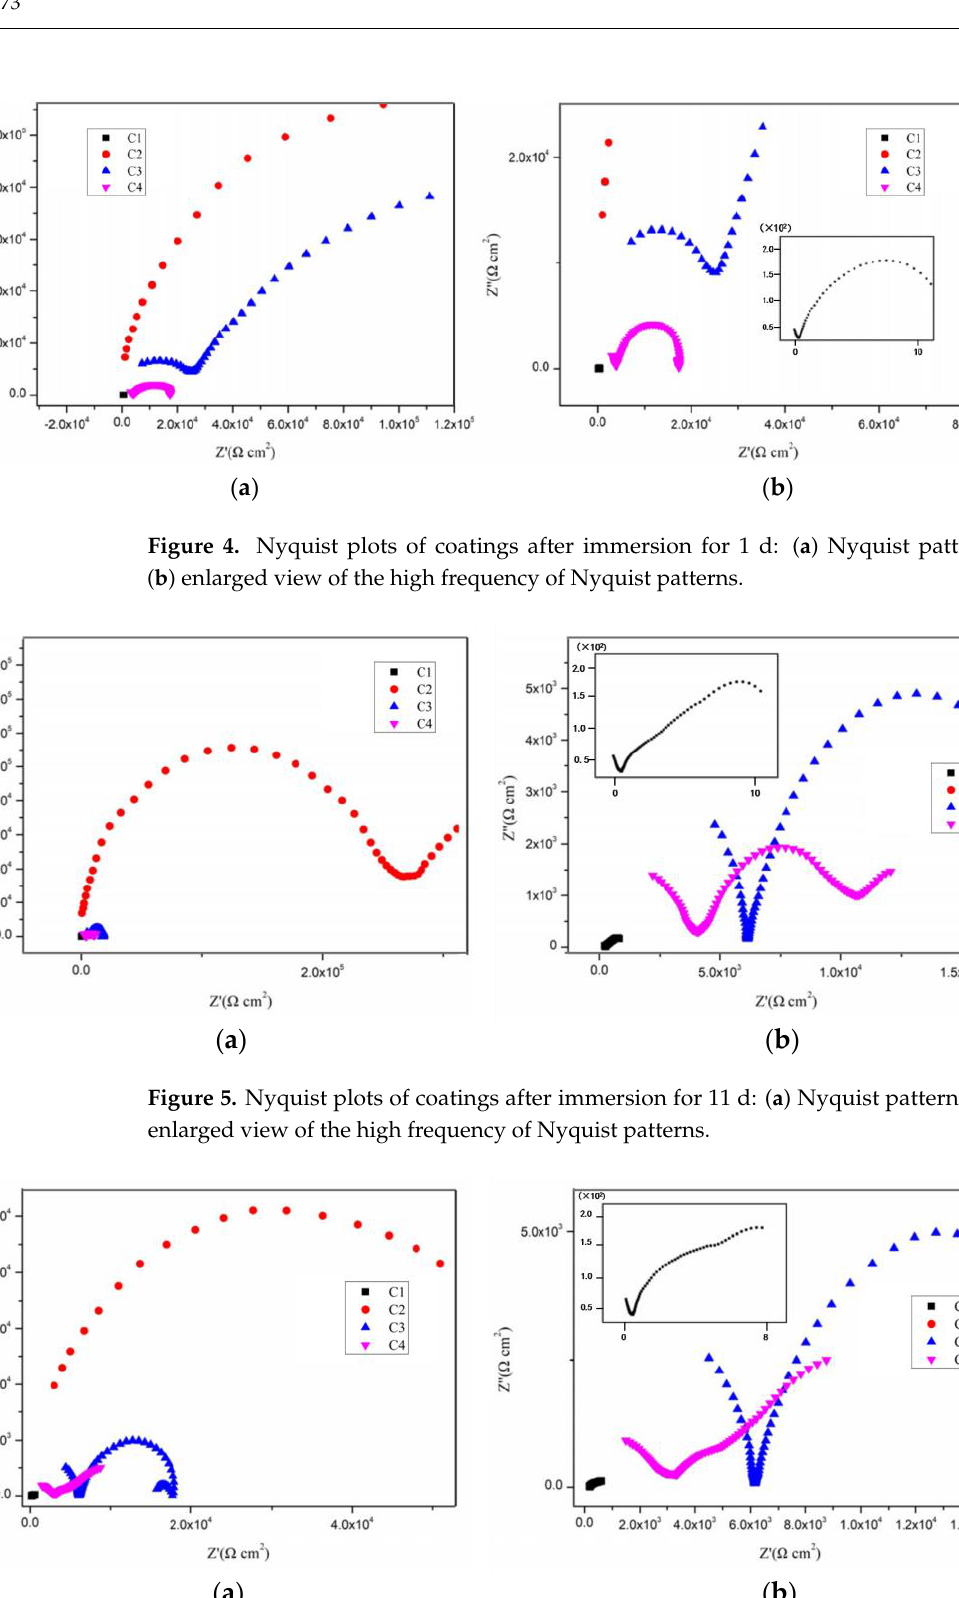
Figure 6. Nyquist plots of coatings after immersion for 21 d: ( a ) Nyquist patterns for 21 d and ( b ) enlarged view of the high frequency of Nyquist patterns.